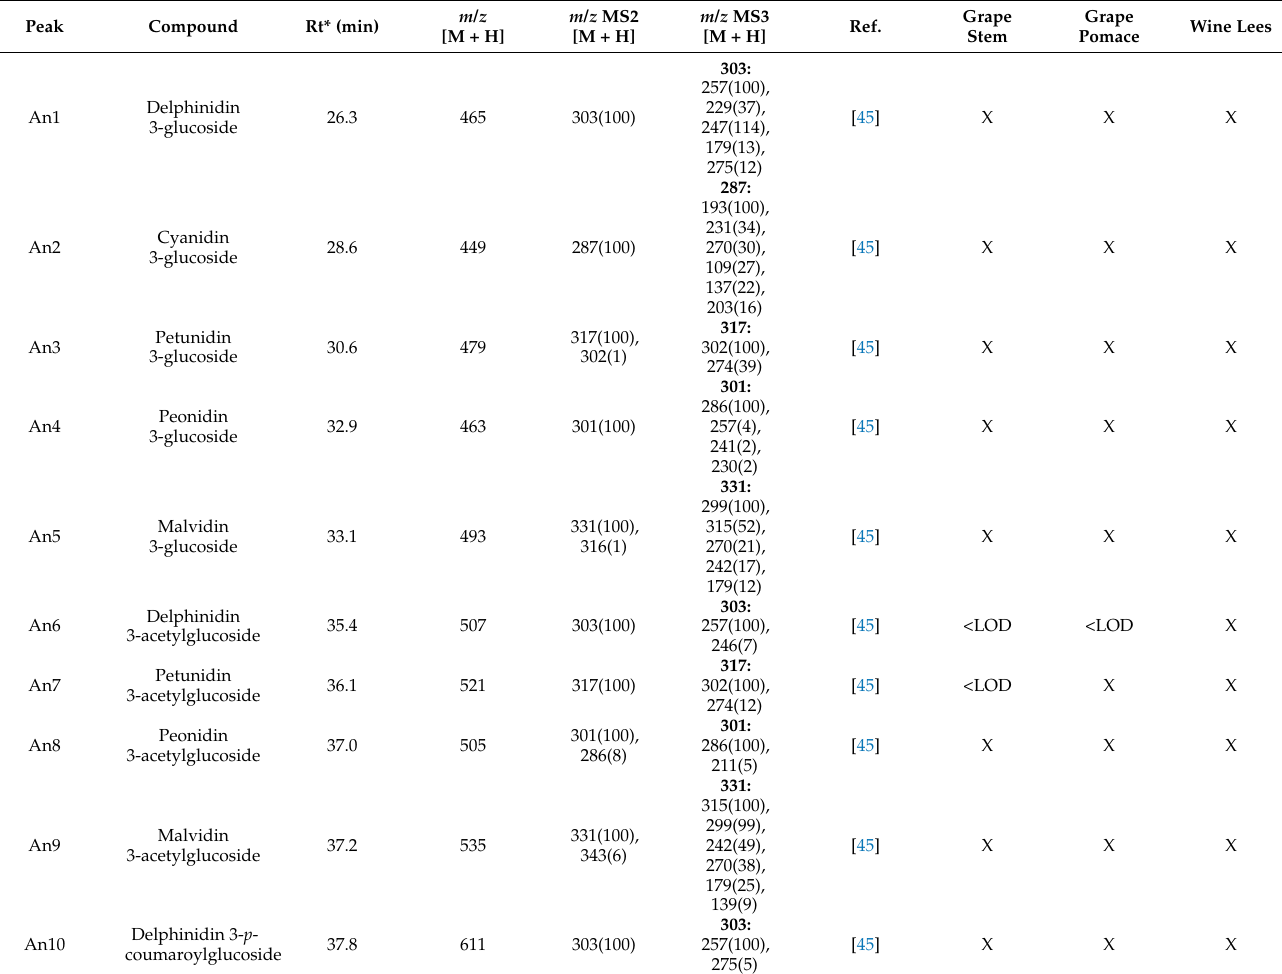
Table 5. Identification of anthocyanins in grape ( Vitis vinifera L. var. ’Monastrell’) stem and pomace, as well as wine lees by HPLC-PDA-ESI-MSn operating in positive mode.